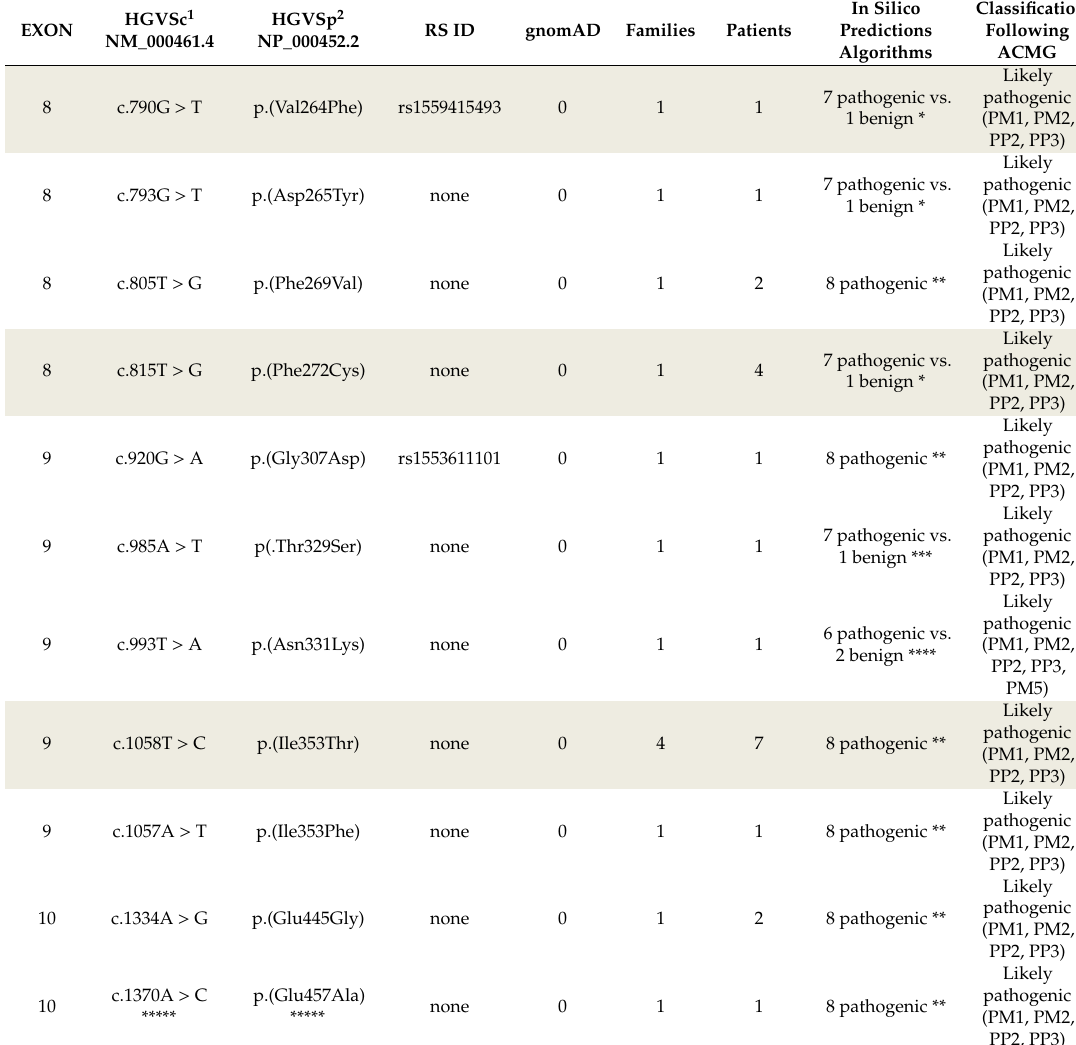
Table 2. Patients with RTH carrying newly described THRB germline variants. Variant features, population database report, in silico predictions of pathogenicity, as well as American College of Medical Genetics and Genomics (ACMG) classification of the newly described THRB variants. HGVSc 1 HGVSp 2 EXON NM_000461.4